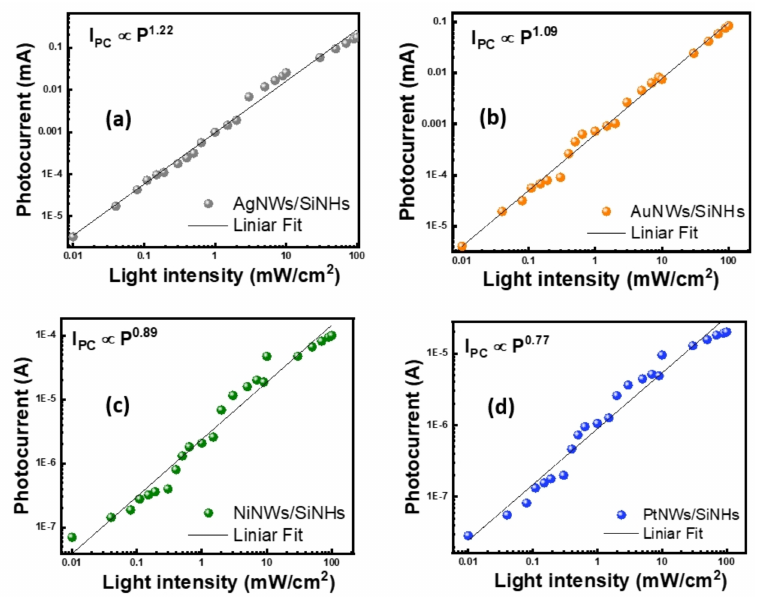
Figure 5. ( a ) Photocurrent dependence on illumination intensity (white light) measured at zero applied voltage of photodetectors based on AgNWs/SiNHs, ( b ) AuNWs/SiNHs, ( c ) NiNWs/SiNHs and ( d ) PtNWs/SiNHs